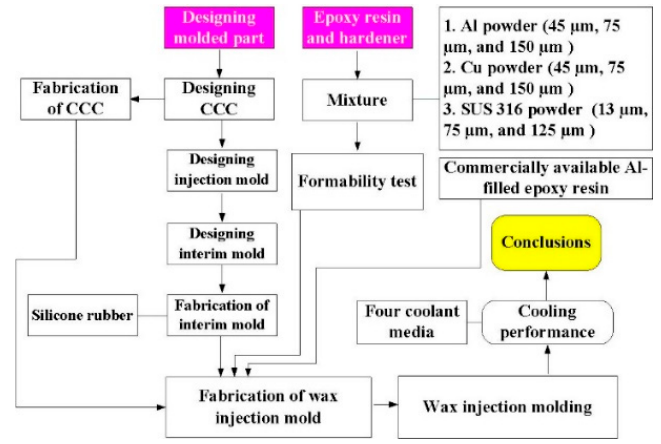
Figure 1. Research process of this